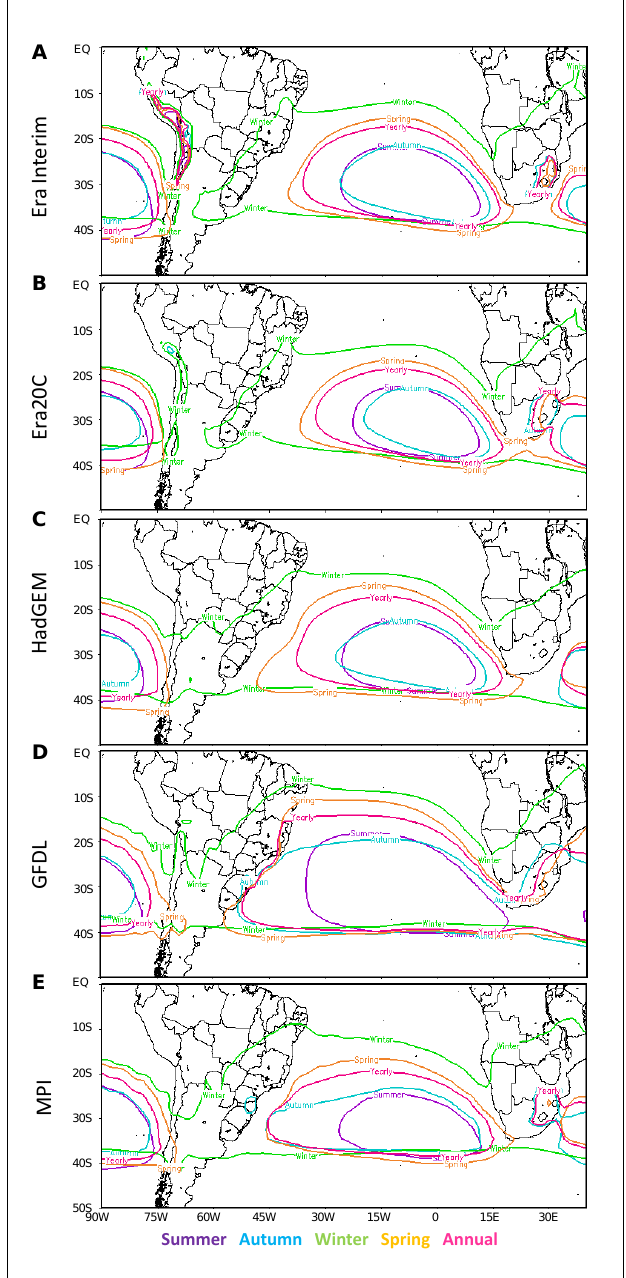
FIGURE 2 | Seasonal and annual climatologies of the 1018 hPa isobar in the present climate (1979–2005) from (A) ERA-Interim, (B) ERA-20C, (C) HadGEM, (D) GFDL, and (E)